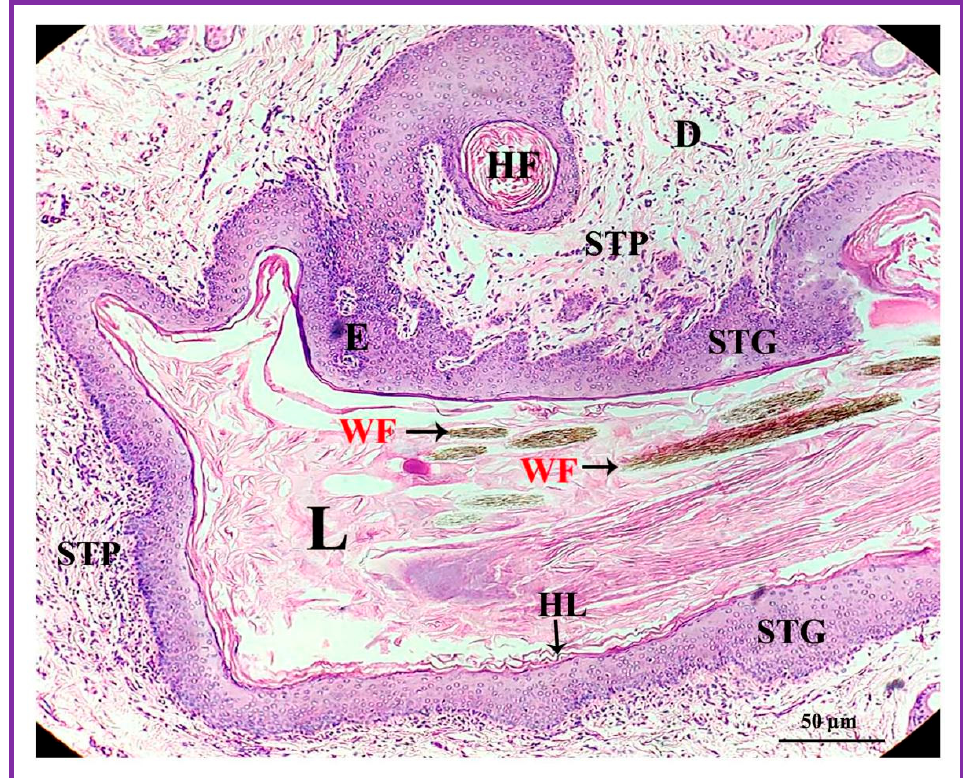
Figure 5. Epidermis (E) of interdigital gland with hyperkeratinized layer (HL), well developed stratum granular (STG) and stratum papillare (STP). The secretory material is present amidst and around the wooly fibers (WF) in the lumen (L). D: dermis; HF: hair follicle.